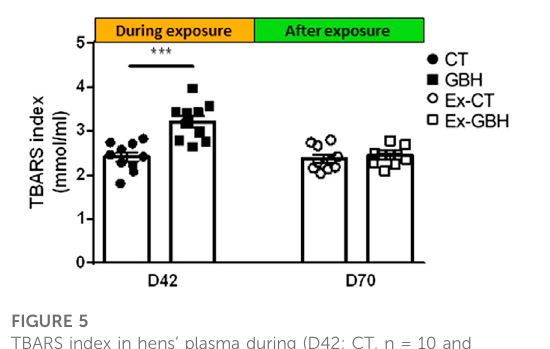
FIGURE 5 TBARS index in hens ’ plasma during (D42; CT, n = 10 and GBH, n = 10) and after (D70; Ex-CT, n = 10 and Ex-GBH, n = 10) GBH exposure. Results are presented as means ± SEM. ***p